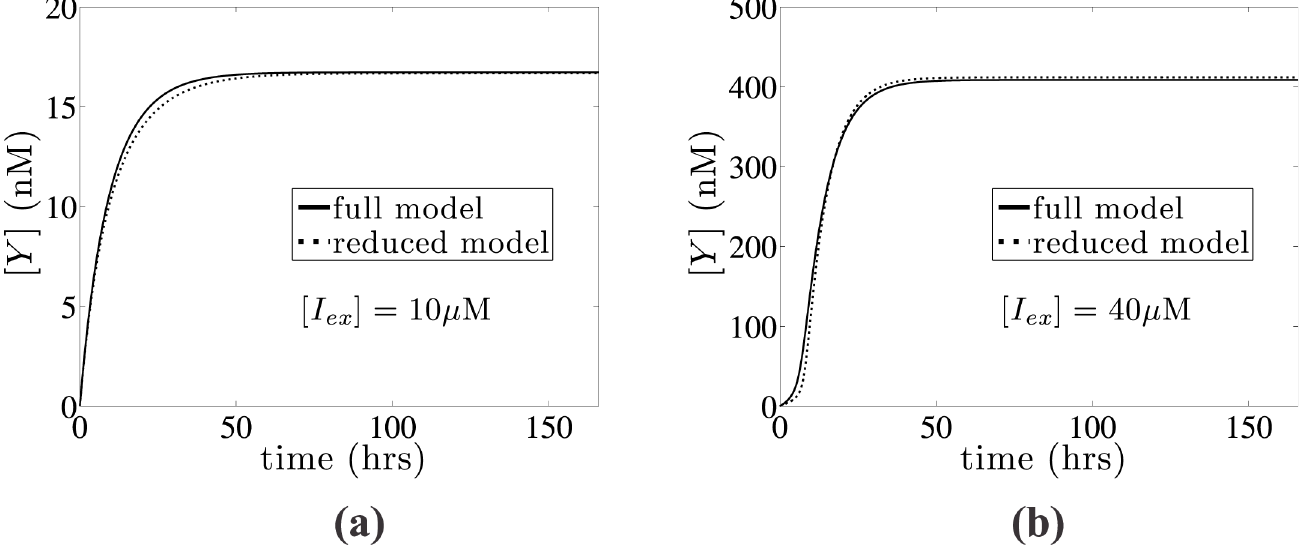
Fig 1. Reduction of deterministic model. Comparison between the full deterministic model (solid line) described by Eqs (2) with the reduced model (dashed line), which is described by Eq (7) for two different external IPTG concentrations leading to (a) an uninduced ([ I ex ] = 10 μ M) and (b) an induced state ([ I ex ] = 40 μ M). Kinetic constants are obtained from Table